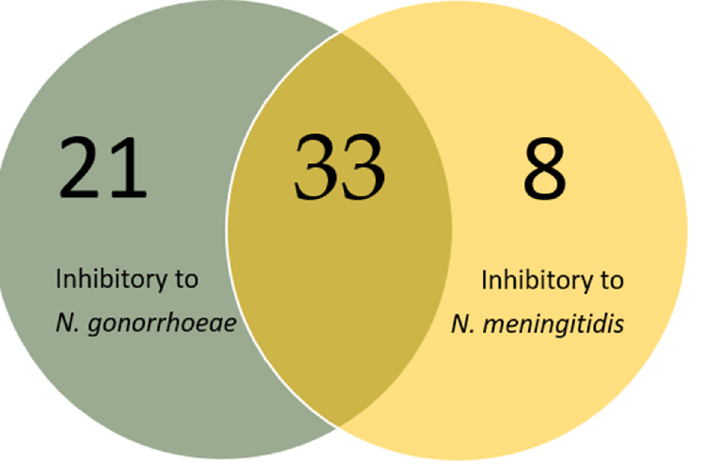
Figure 2. The number of isolates found to be inhibitory to two pathogenic Neisseria species. All 62 inhibitory isolates were identified by MALDI-TOF MS and they belonged to the genus Streptococci (12 species) and genus Rothia (2 species) (Table 2). The most prevalent species were S. parasanguinis (14; 22.6%), S. sanguinis (10; 16.1%) and S. mitis (8; 12.9%). One isolate each belonging to R. mucilaginosa , S. gordonii , S. infantis and S. peroris